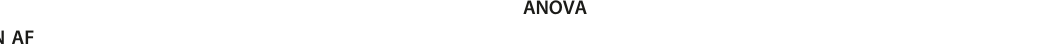
Sum of Squares df Mean Square